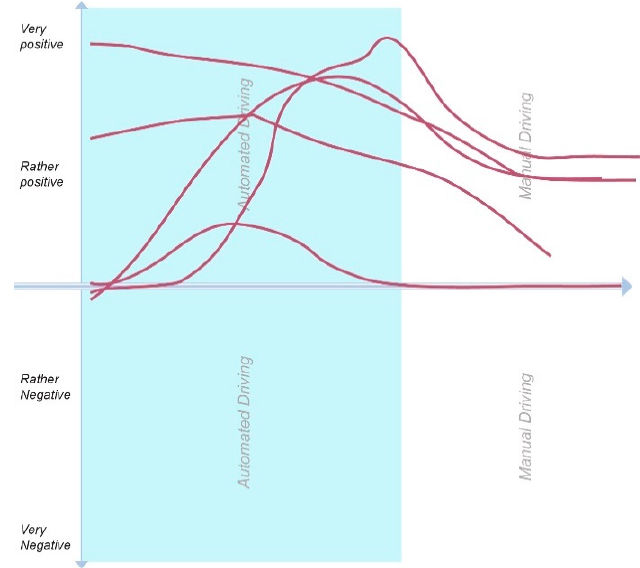
Figure 3. Curves with downward inclination.